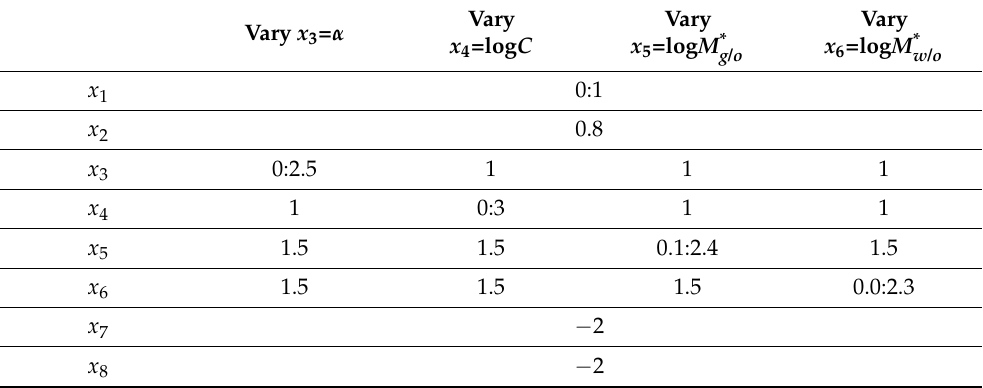
Table 7. Parameter selections for MOD2 cases to check response in going from multiphase to single- phase